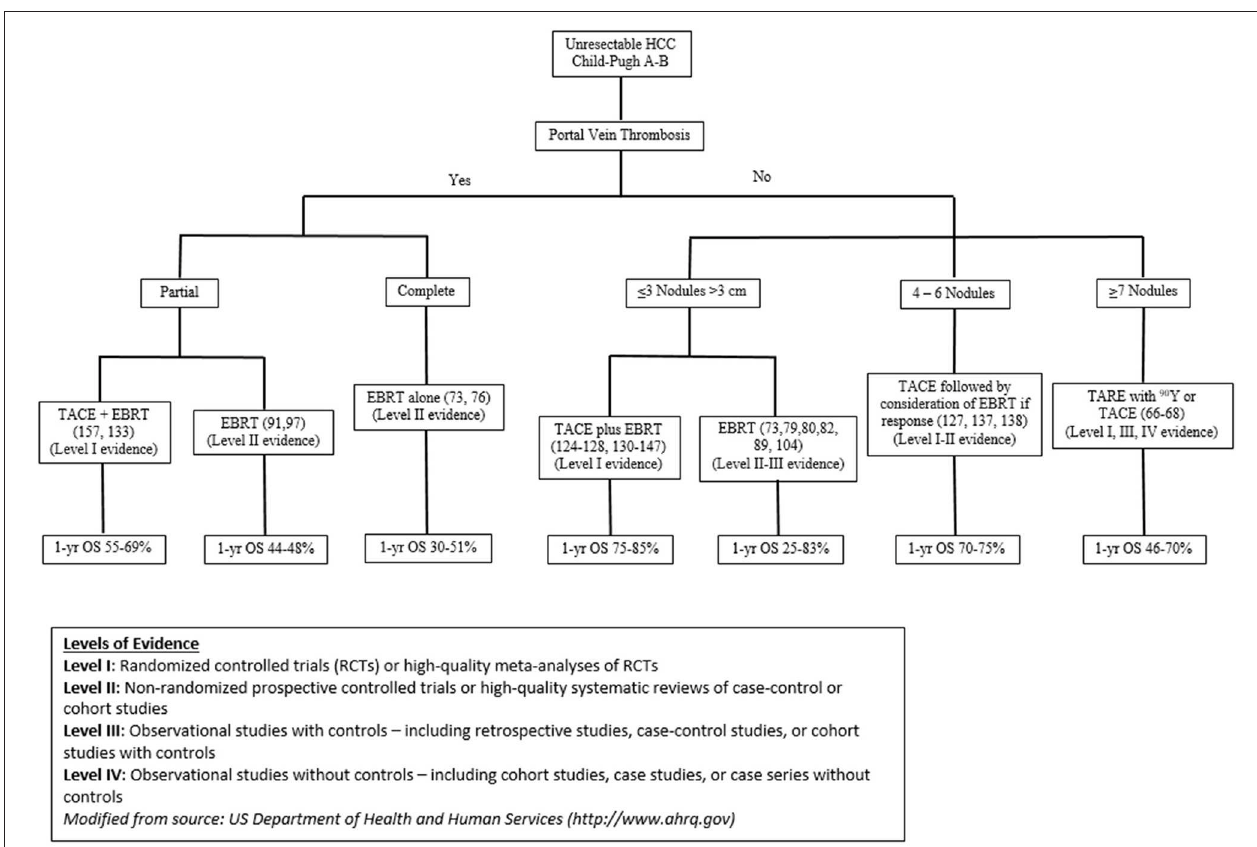
FIGURE 1 | Data driven Rutgers treatment algorithm for optimizing outcomes for unresectable HCC